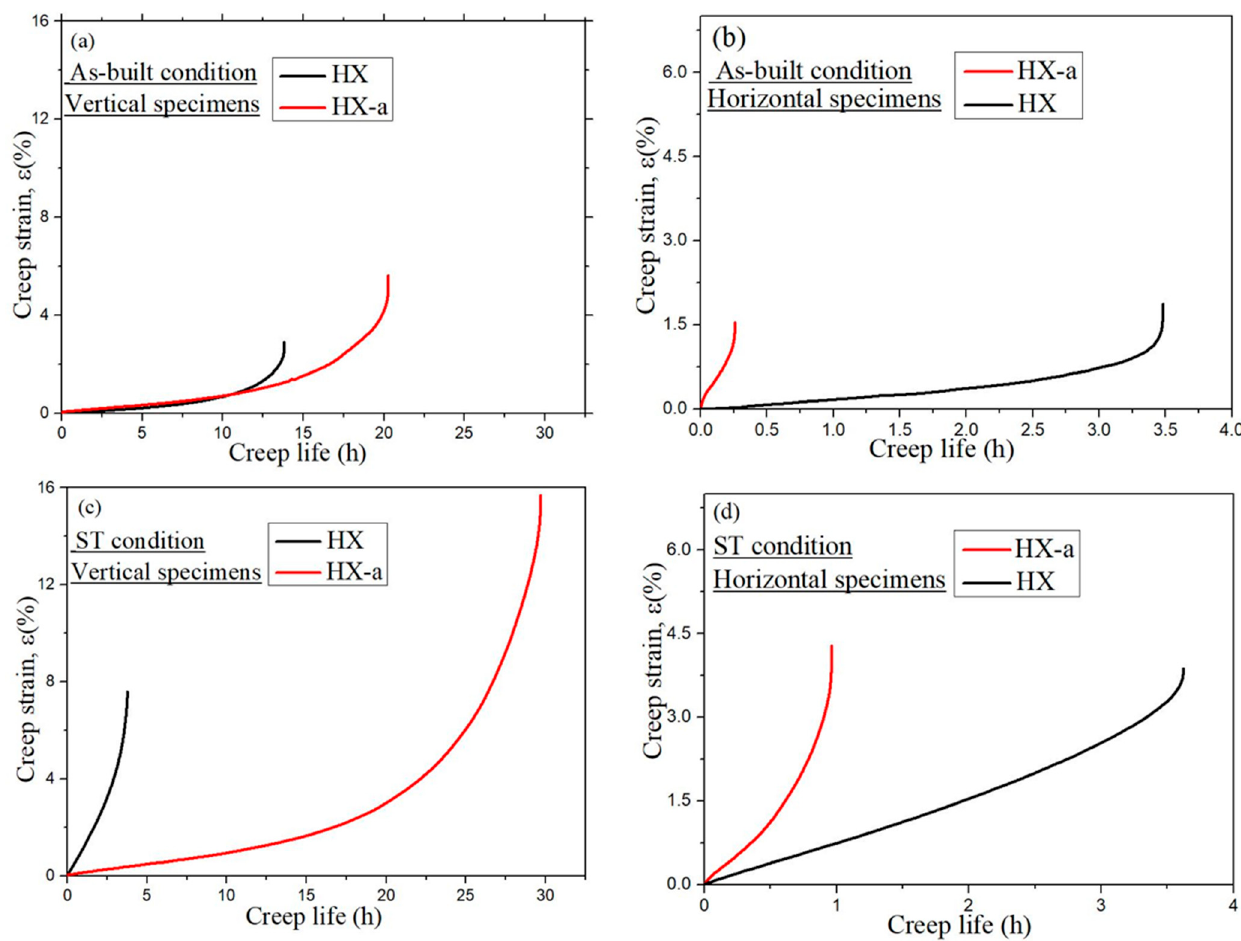
Figure 10. Creep curves of HX and HX-a specimens at 900 °C under 80 MPa: ( a ) as-built vertical, ( b ) as-built horizontal, ( c ) ST vertical, and ( d ) ST horizontal specimens.